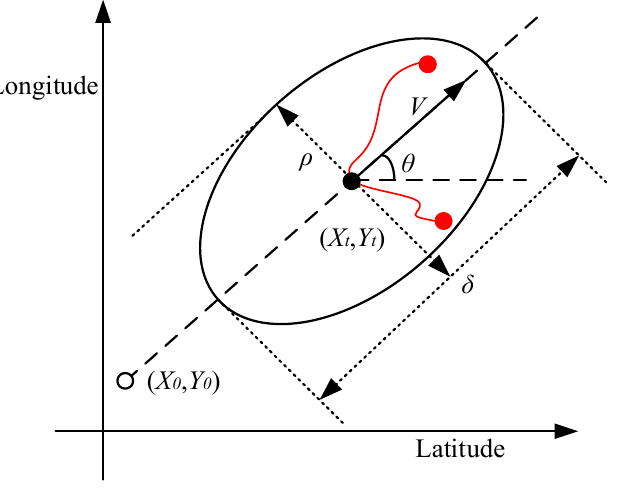
Figure 5. Schematic diagram of the dynamic tolerance region of a